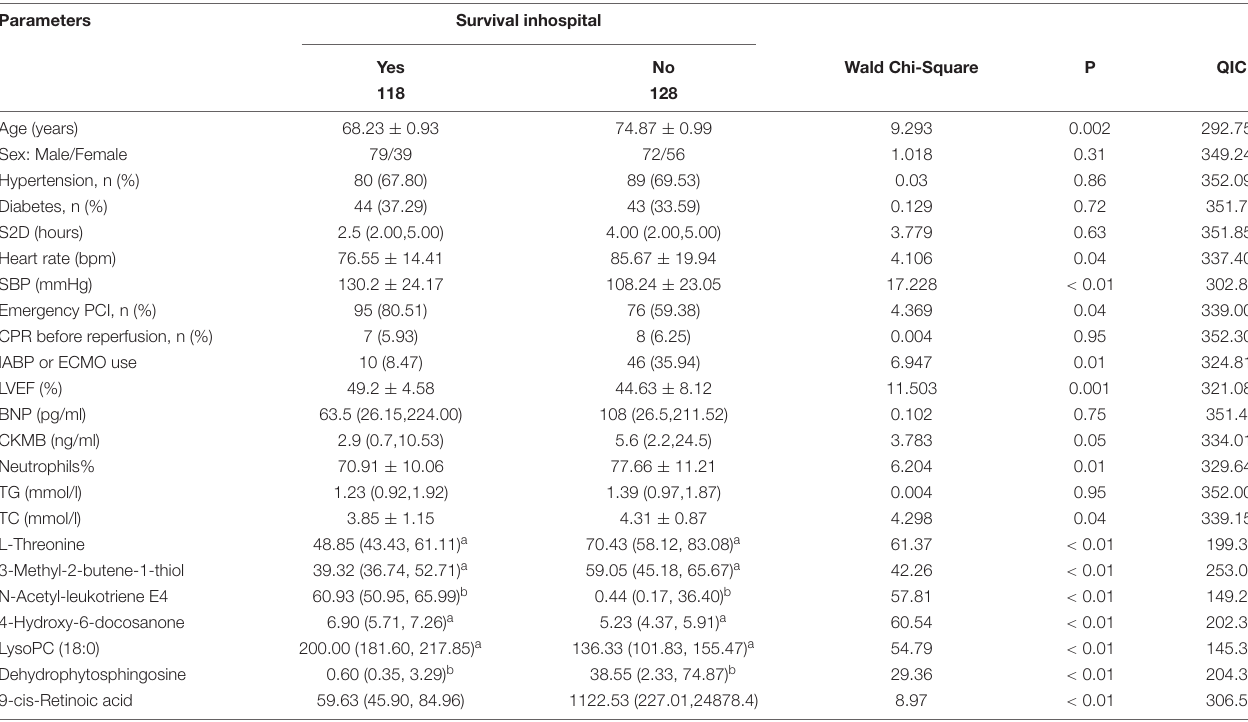
TABLE 4 | Relationships between baseline parameters (clinical parameters combined with biomarkers) and inhospital outcome of patients with ST-segment elevation myocardial infarction (STEMI) in univariate generalized estimating equation (GEE) models. Parameters Survival inhospital